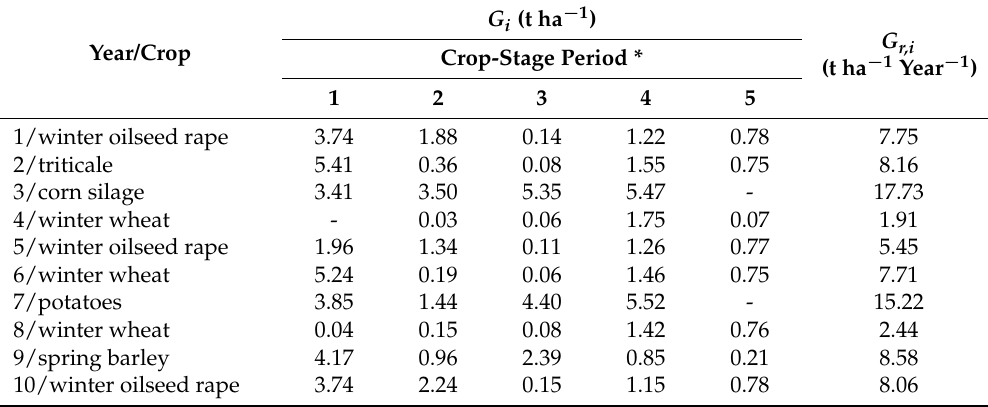
Table 2. Partial and average annual soil losses from 1004/1